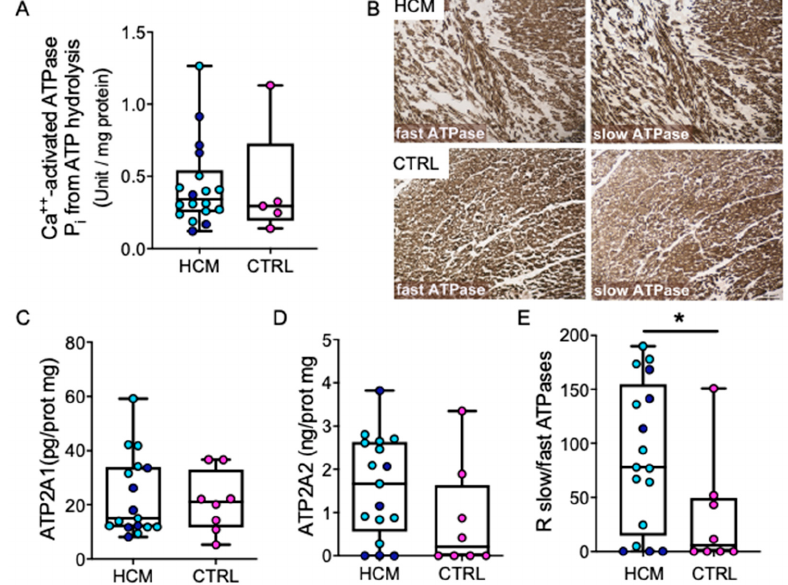
Figure 3. Ca2+-activated ATPases. Quantification of P i from ATP hydrolysis by Ca 2+ -activated ATPase in myocardial tissue extracts enriched for myosins is plotted. ( A ) Left atrium from a donor heart and skeletal muscle extracts are used as technical controls. Representative histochemistry images showing the homogeneous distribution of active fast and slow ATPase on cryosections from HCM and CTRL are shown ( B ). Notice the absence of difference in the brown signal intensity, irrespective of the presence of disarray in the HCM field. Tissue contents of fast (ATP2A1, ( C )) and slow (ATP2A2, ( D )) ATPase and their ratio measured by ELISA in extracts from HCM ( n = 17) and CTRL ( n = 8) are shown ( E ). Data are presented as boxes (min to max) and dots indicate single sample values. Dark blue dots indicate HCM patients with mutation, light blue dots those without. Mann–Whitney test was applied and significant difference is shown as * p <